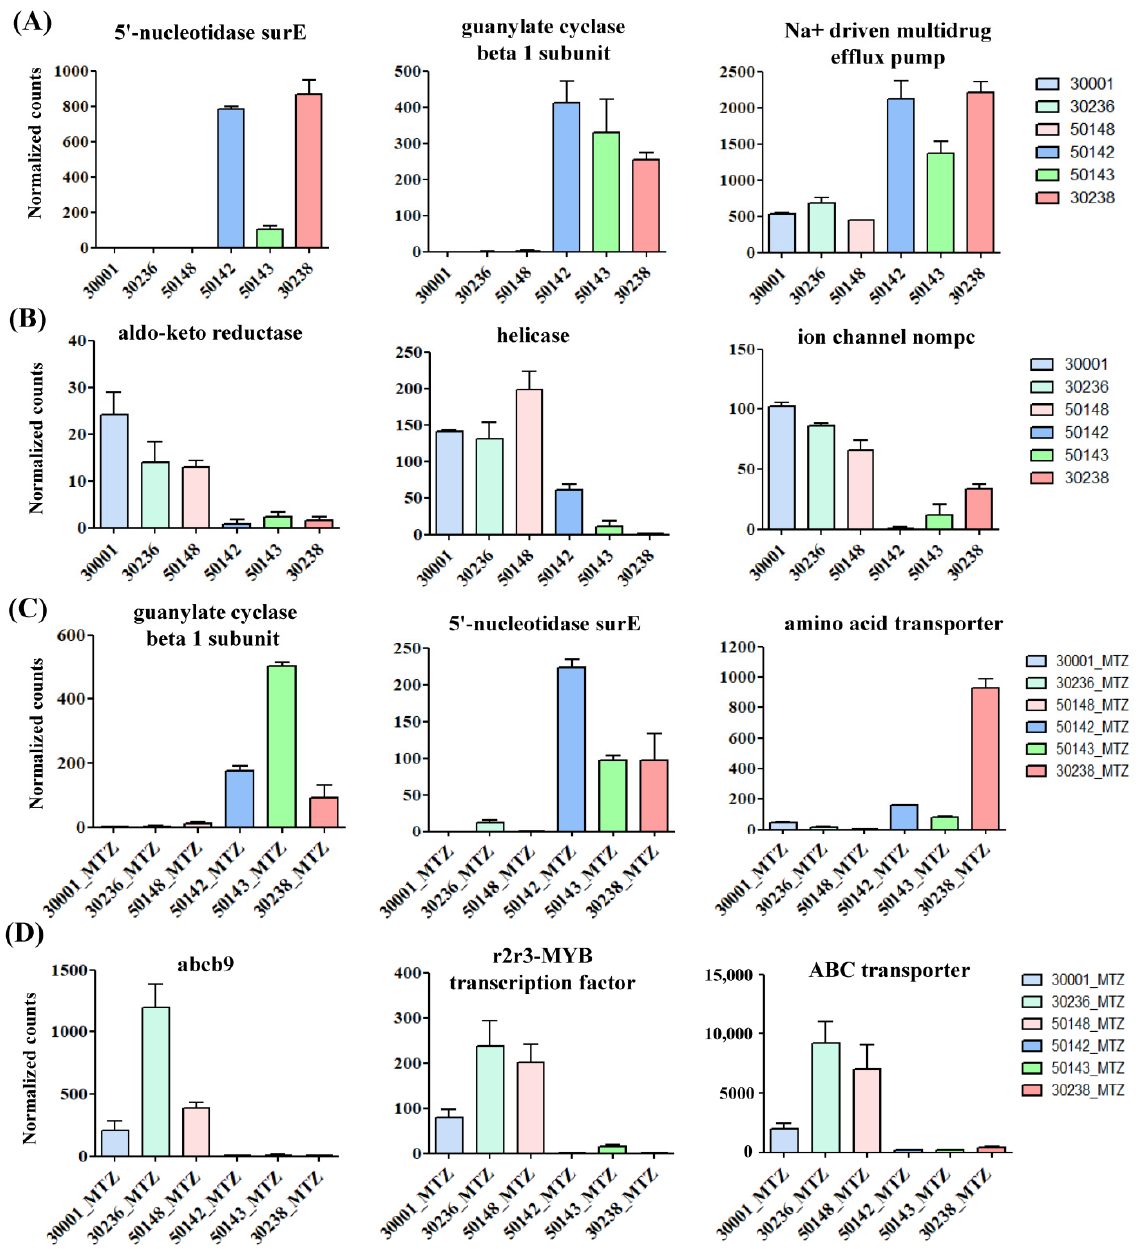
Figure 5. Commonly upregulated and downregulated genes in the MTZ-R T. vaginalis transcriptomes treated with or without MTZ. The selected genes were observed to be upregulated ( A ) and downregulated ( B ) in the MTZ-R transcriptomes (50142, 50143, and 30238) compared with those of MTZ-S (30001, 30236, and 50148). Upon MTZ treatment, the selected upregulated ( C ) and downregulated ( D ) genes in the same MTZ-R strains in comparison with the MTZ-S strains were also analyzed. Gene expression levels were presented as mean ± SD of normalized count values obtained from three independent RNA-seq experiments.